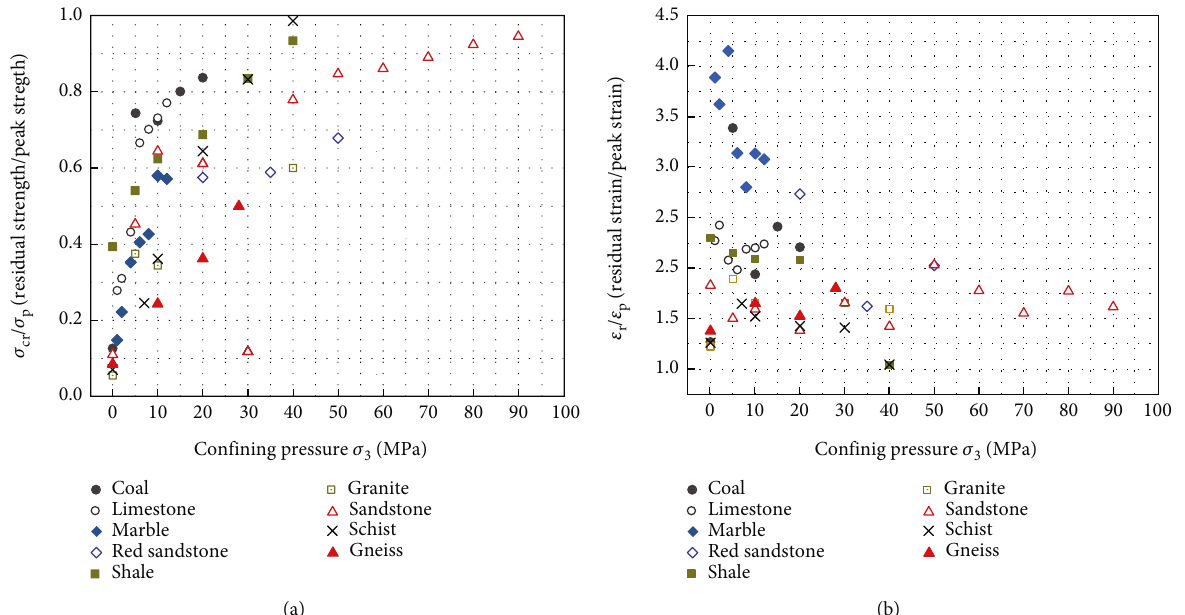
Figure 6: Variation trend of strength ratio and strain ratio of coal and rock mass with con fi ning pressure: (a) strength ratio and (b) strain